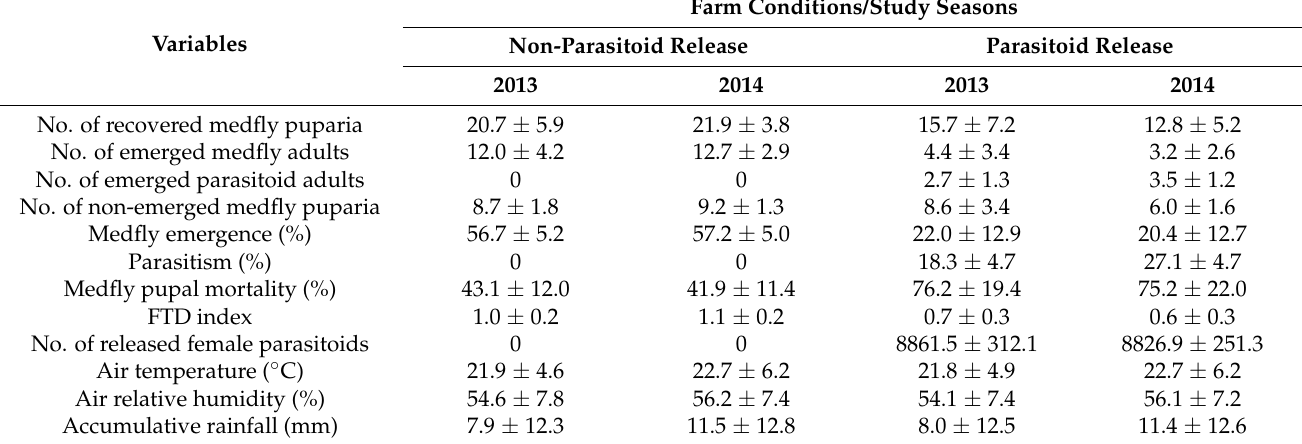
Table 1. Mean ( ± SD) values of response variables tested under parasitoid release and non-release conditions. Mean and SD were estimated for the averaged database by release